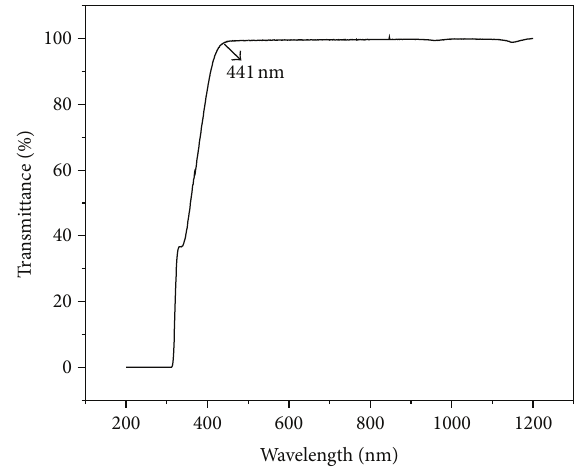
F 2: Optical transmission spectrum Cu